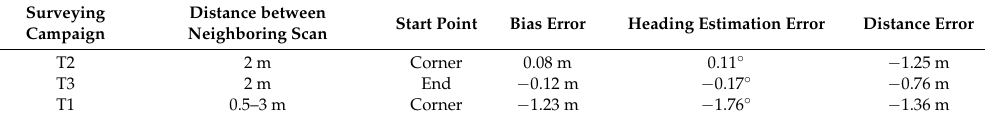
Figure 8. Matterport mapping results with different trajectories ( a ) 2 m mapping distance, linear trajectory and different start point; ( b ) 0.5–3 m mapping distance, matrix trajectory. Table 4. Comparison of Matterport output with different mapping